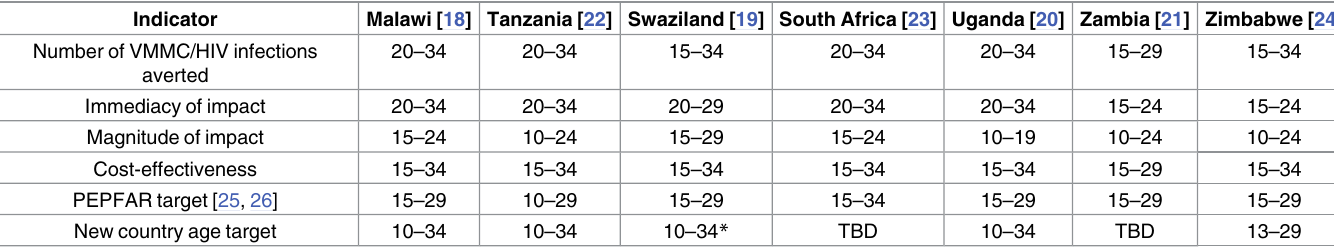
Table 1. Priority country-specific age groups by indicator of